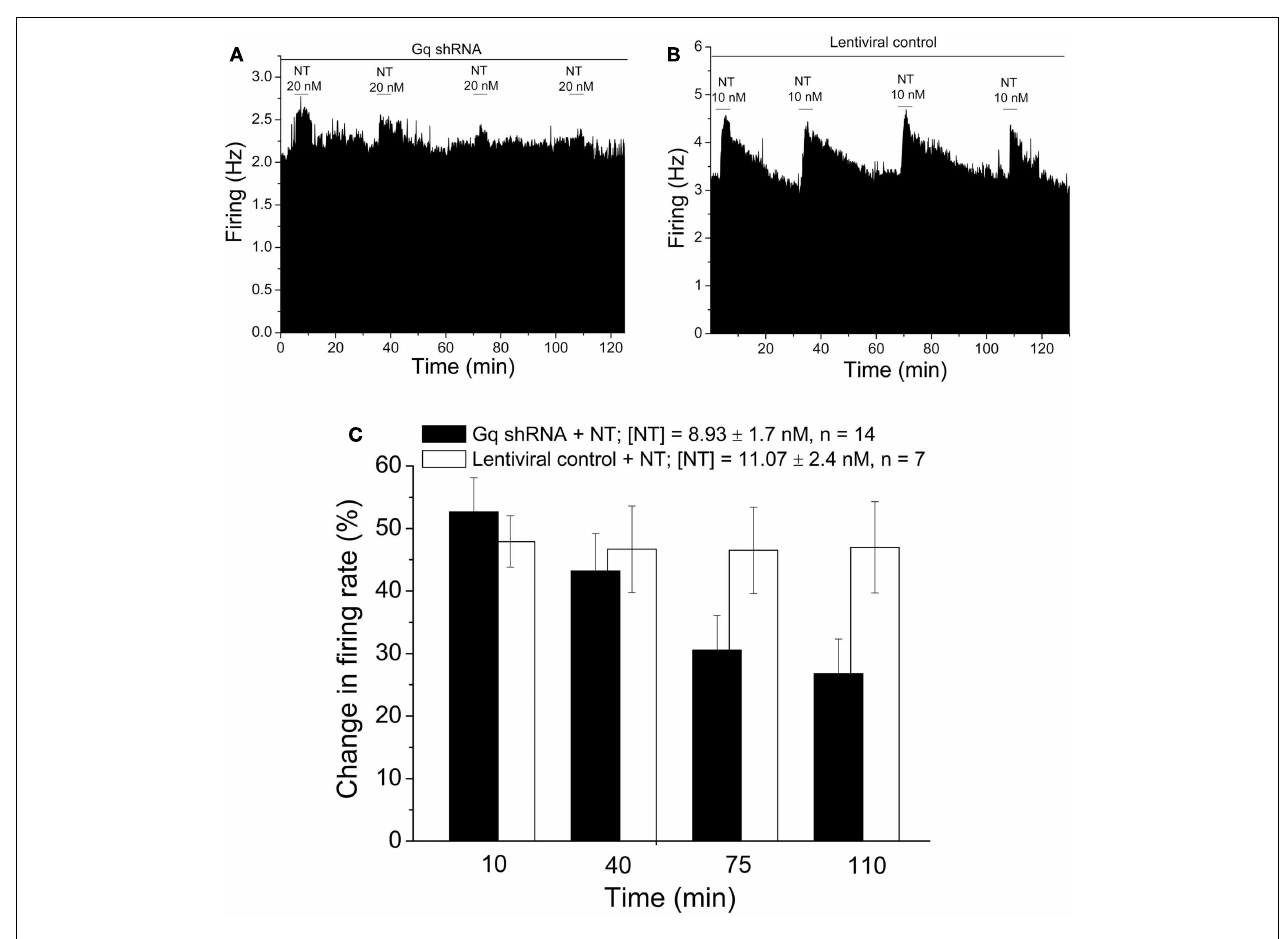
respectively; the magnitude of neurotensin excitation over time in the recording shown in (B) was 58.5, 62.8, 61.3, and 56.4%, respectively. (C) Bars representing the mean responses to neurotensin in recordings similar to those shown in (A,B) . Mean excitatory effect of neurotensin is shown at each time period for cells recorded with micropipettes to which Gq shRNA (filled bars) or lentiviral control (open bars) was added.There was a significant change in the excitatory effect of neurotensin in recordings in which Gq shRNA was present in the